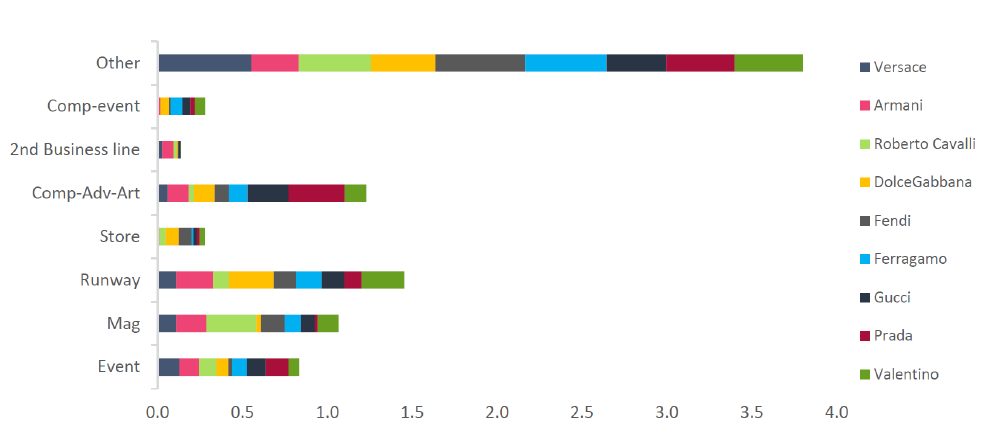
Figure 7. Share of each different context category for each